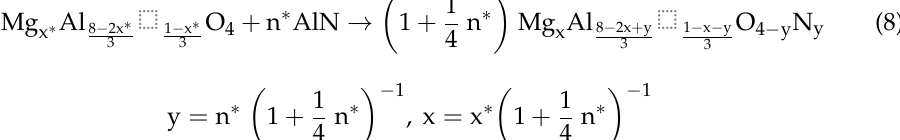
Equation (7), with cation vacancies marked as ⬚ , and n and x * being stoichiometric